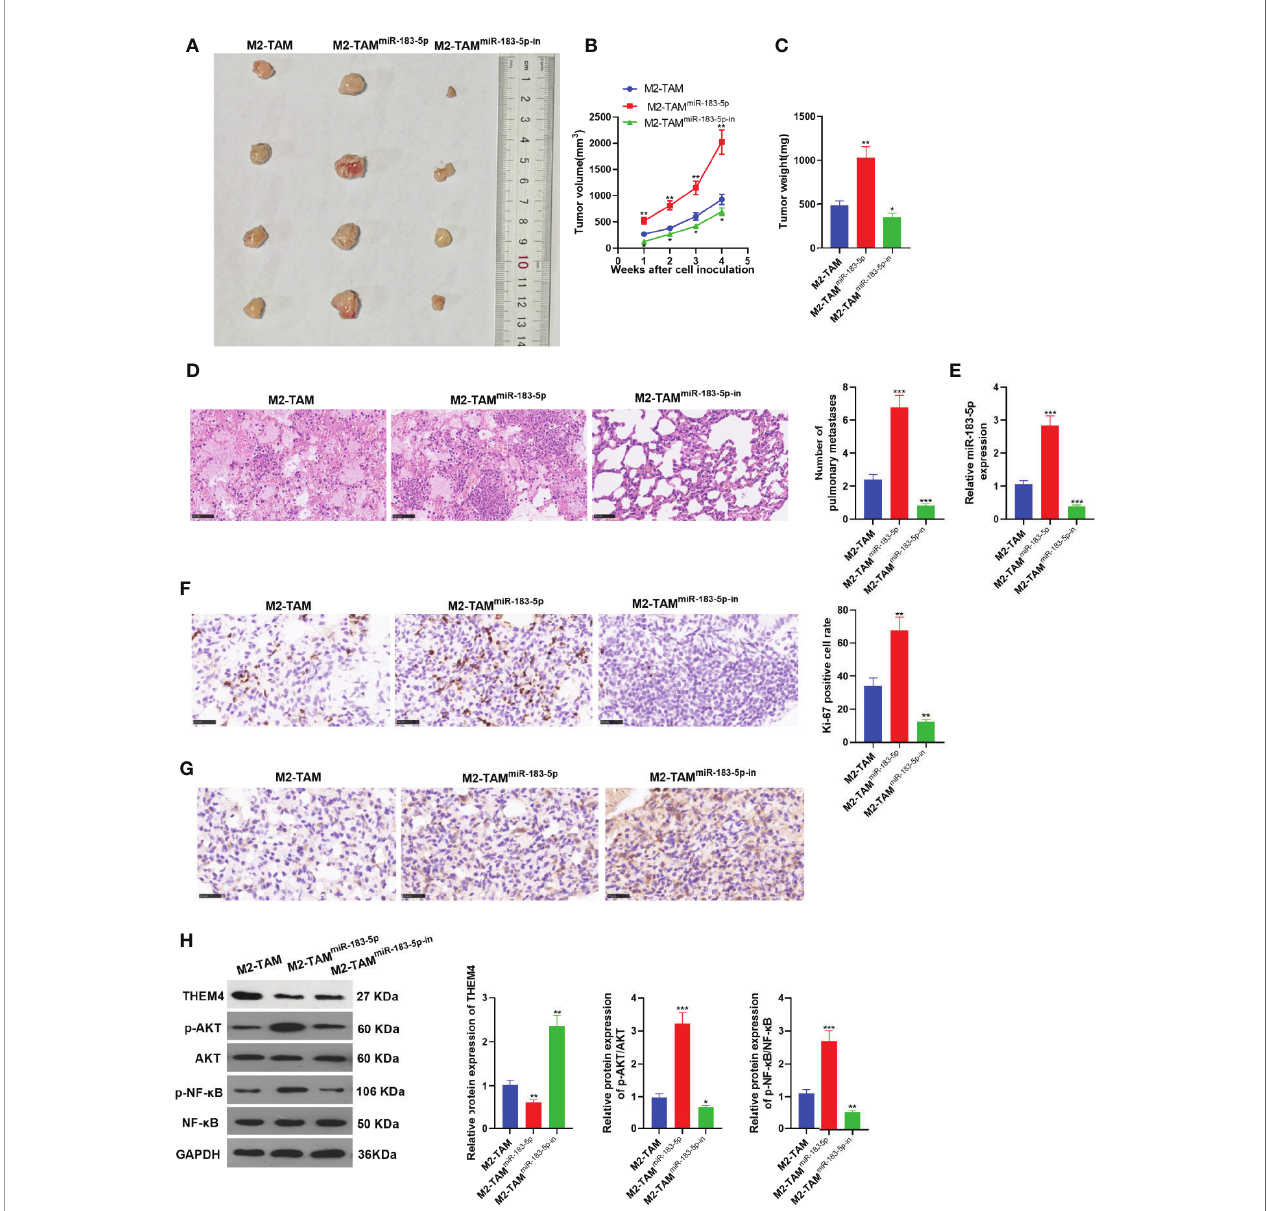
FIGURE 8 | miR-183-5p enriched M2-TAM-Exo heightened the proliferation and metastasis of CC cells in vivo . The xenograft model was constructed to observe the effect of miR-183-5p in vivo . (A) The fi gure of xenograft tumor. (B, C) Tumor volume and weight. (D) H&E staining. (E) The miR-183-5p pro fi le in the xenograft tumor was determined veri fi ed by qRT-PCR. (F, G) The levels of Ki67 and THEM4 were compared by IHC. (H) The relative expression of THEM4, AKT and p-NF- k B in tumor tissues of each group was tested by WB. * P < 0.05, ** P < 0.01, *** P < 0.001 ( vs . M2-TAM group).